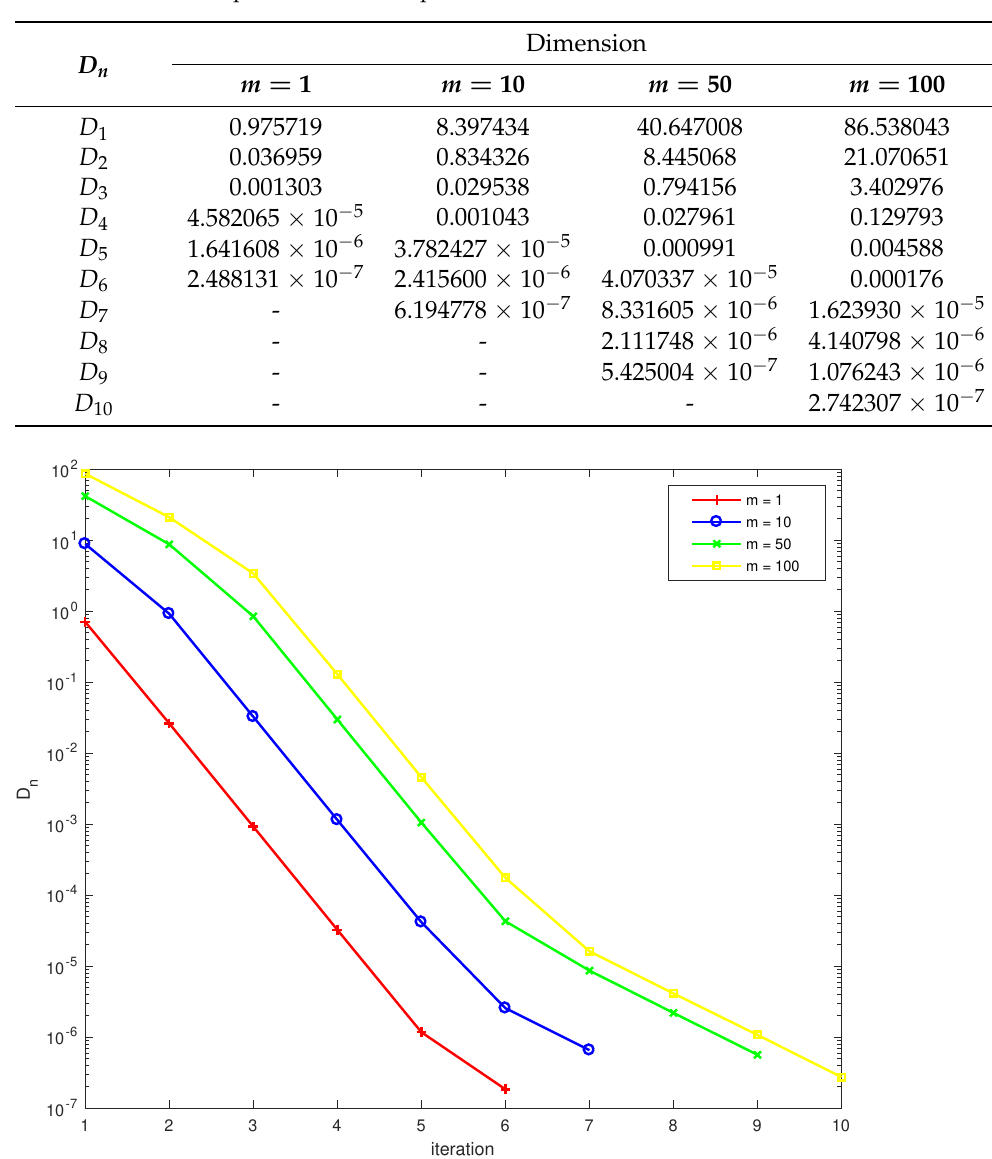
Table 3. Numerical experiments of Example 3.